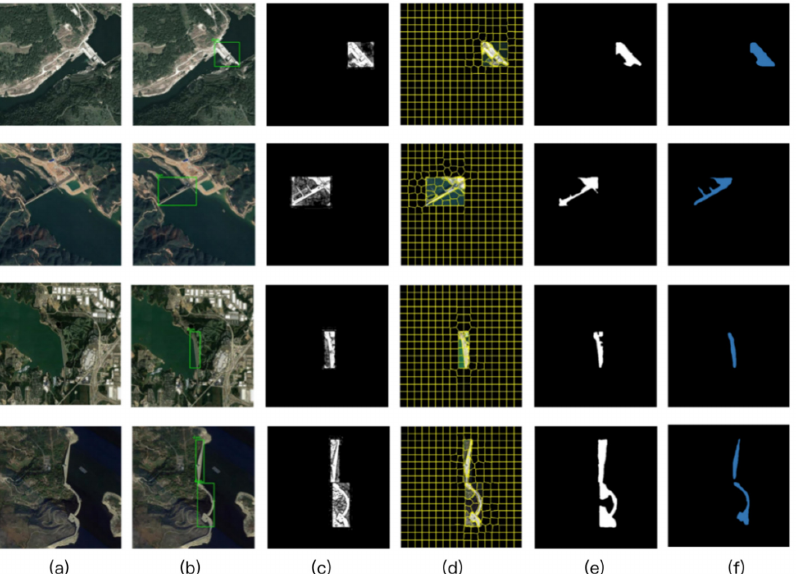
Figure 13. Processes of dam segmentation. ( a ) Original images: randomly selected from validation samples of RSDams. ( b ) Dam detection results: the bounding boxes are the visualizations of the results for dam detection. ( c ) MBI feature images: increasing MBI values from black to bright white. ( d ) SLIC images: visualization for superpixels using SLIC operation. ( e ) Dam segmentation results: the white areas are dam bodies, and the black ones are background. ( f ) The results according to a visual interpretation: the blue areas are dam bodies, and the black ones are background.